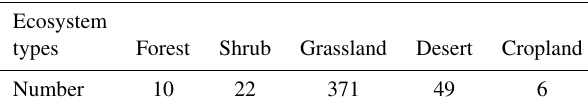
Table 2. Number of soil sample points of different ecosystems in the Third Pole region.